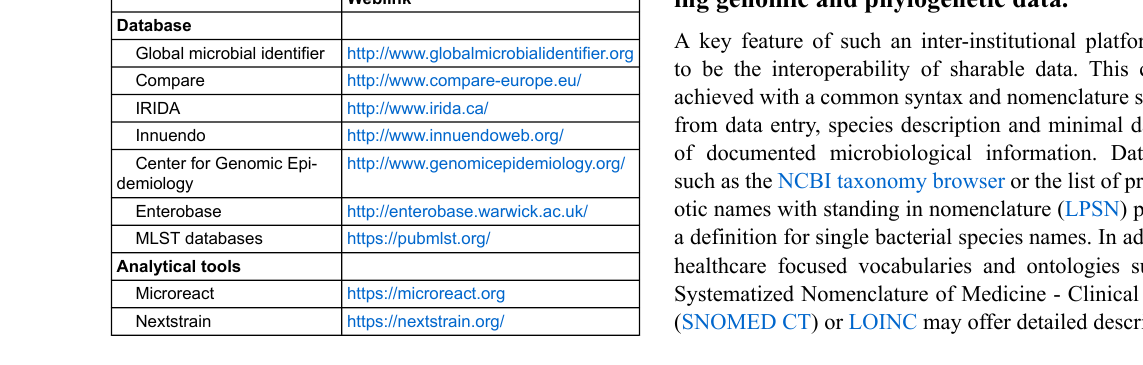
Table 2: Selection of surveillance databases, initiatives, and analytical tools using whole genome sequence information from pathogens Weblink